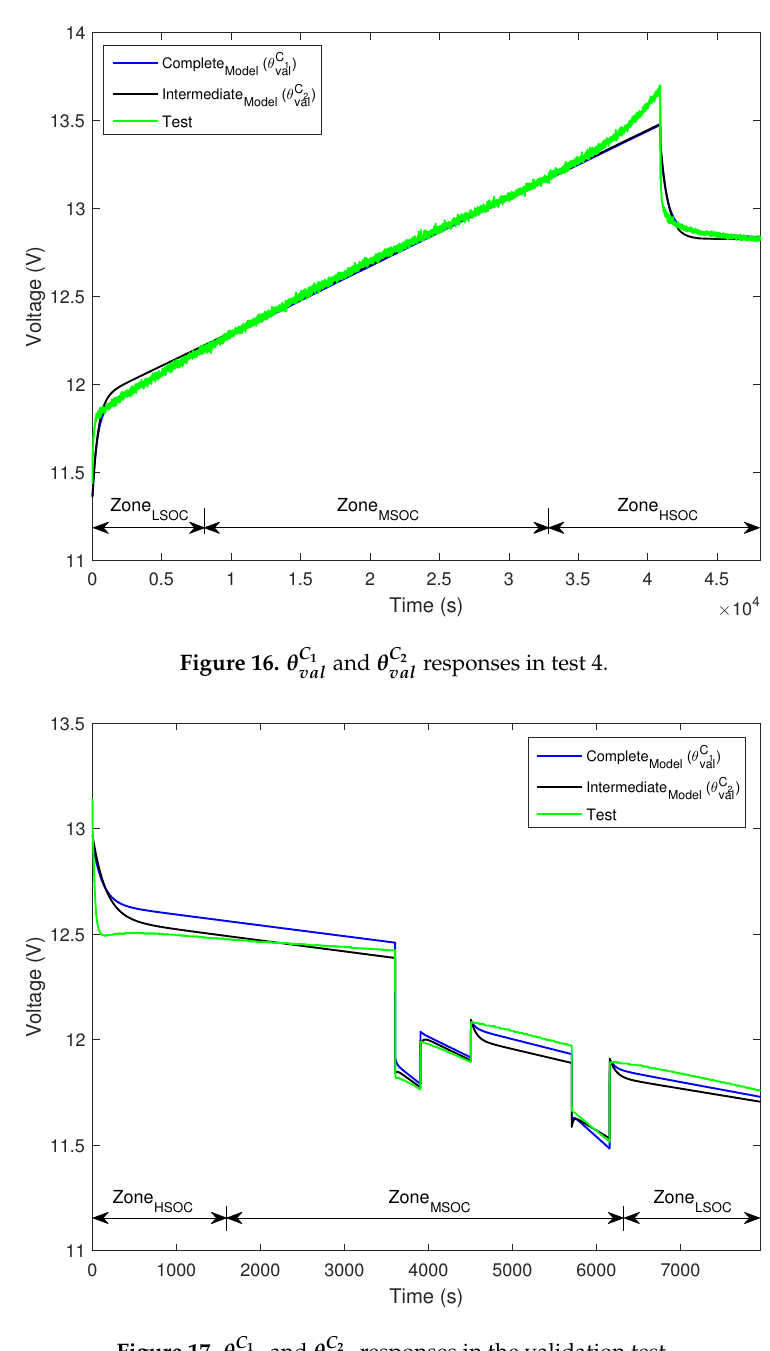
and θ C 2 responses in the validation val val